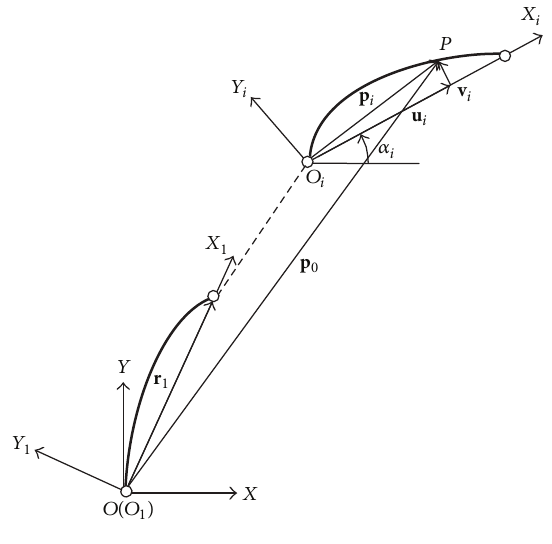
Figure 2: Model of the boom